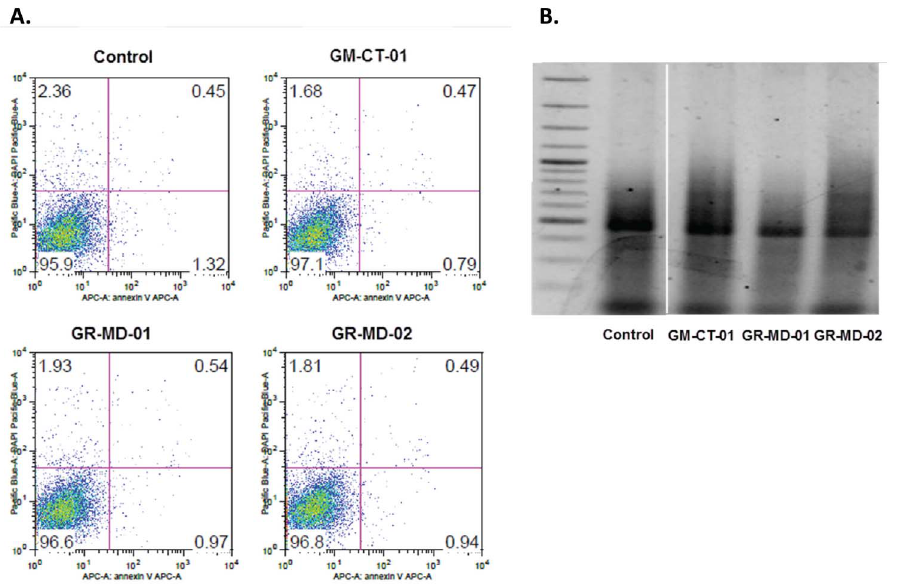
Figure 11. Evaluation of LX-2 cells for apoptosis. A. Fluorescent activated cell sorting following treatment with Annexin V apoptosis detection kit APC (Ebioscience). B. 2% agarose gel, stained with ethidium bromide, and visualized by transillumination with UV light after using Apoptotic DNA Ladder Extraction Kit (BioVision, Mountain View. Samples were all analyzed on same gel; discontinuity on the figure is due to the removal of repeated samples of different lots of GM-CT-01 which gave same results.